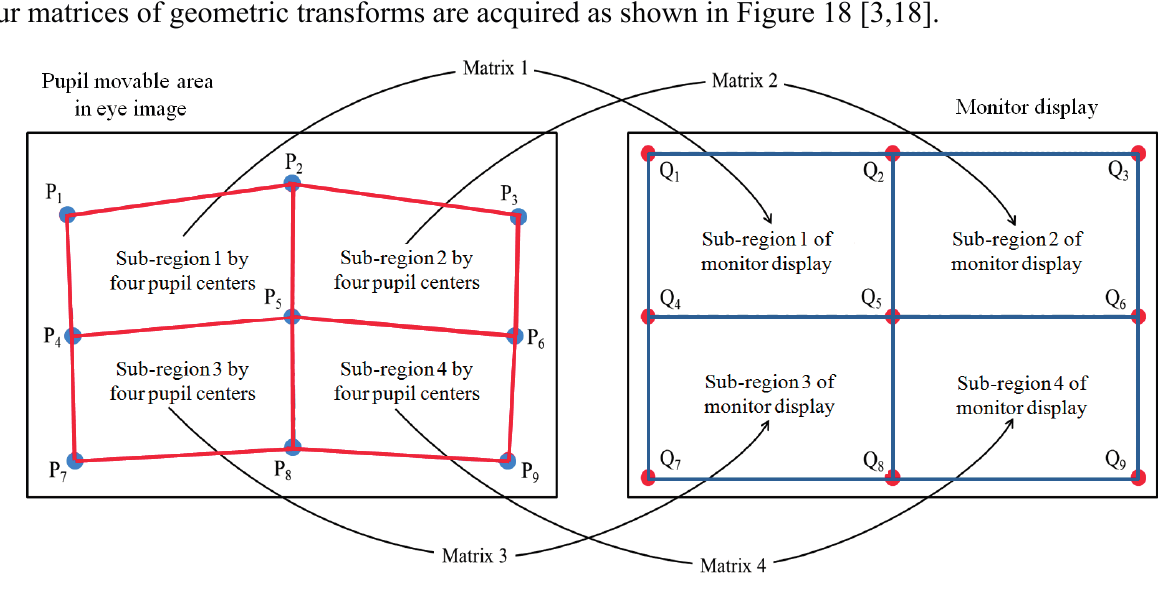
Figure 18. Relationship between four sub-regions defined by nine pupil centers and the corresponding four sub-regions of monitor